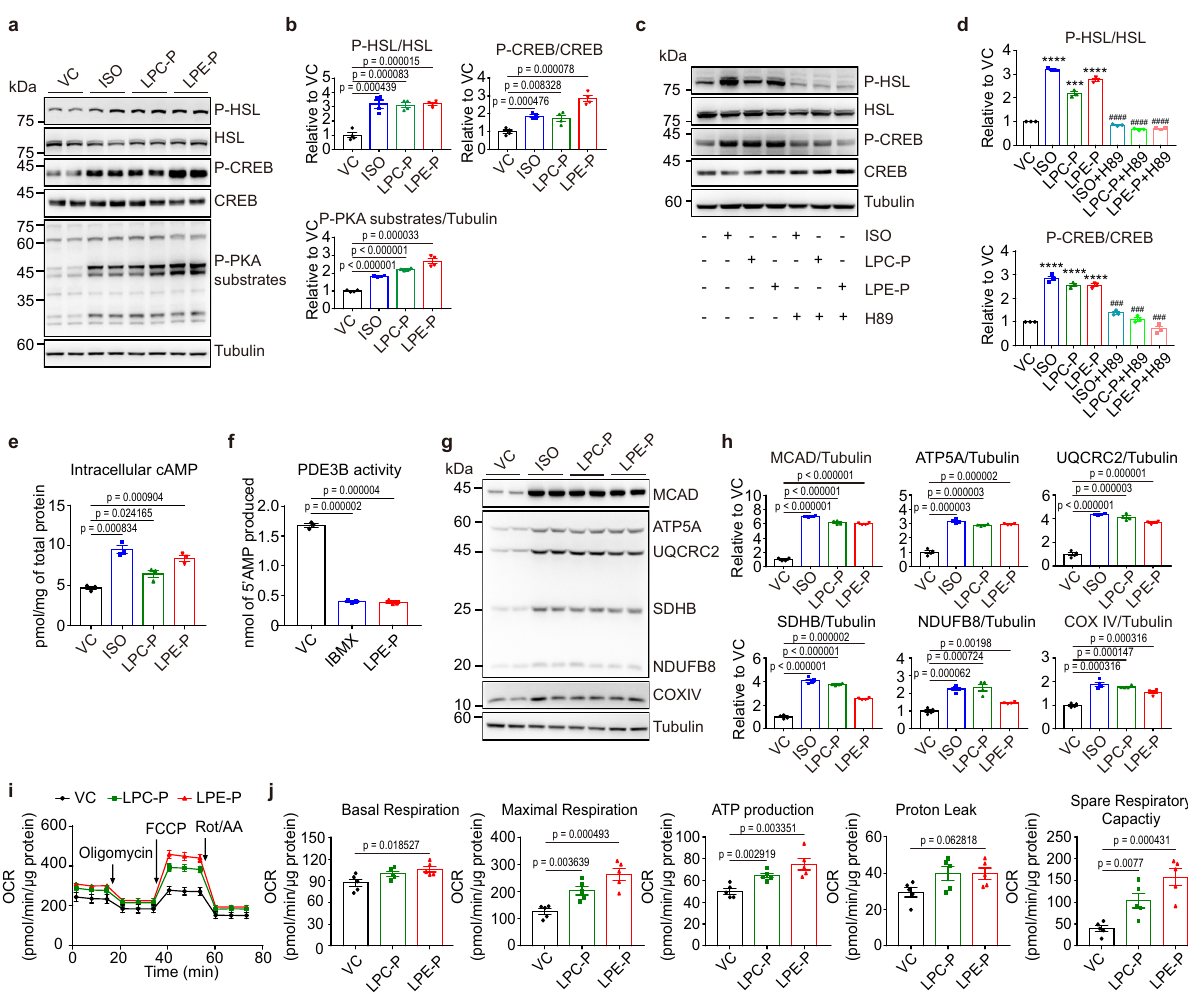
Fig. 7 In vitro LPE P-18:0 treatment elevates intracellular cAMP levels and activates PKA signalling via inhibition of PDE activity. a , b Immunoblot analysis of C3H10T1/2 adipocytes treated with vehicle control (VC), LPC P-18:0 (LPC-P, 10 μ M) or LPE P-18:0 (LPE-P, 10 μ M) for 24 h or isoproterenol (ISO, 10 μ M) for 4 h. n = 4. c , d Immunoblot analysis of C3H10T1/2 adipocytes treated with VC, ISO (10 μ M), LPC-P (10 μ M), LPE-P (10 μ M), ISO (10 μ M)